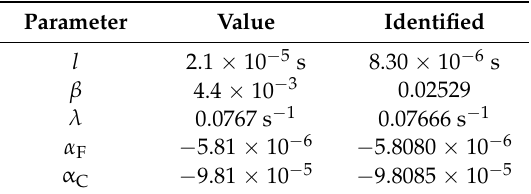
Table 3. Model parameters for core neutron dynamic module.